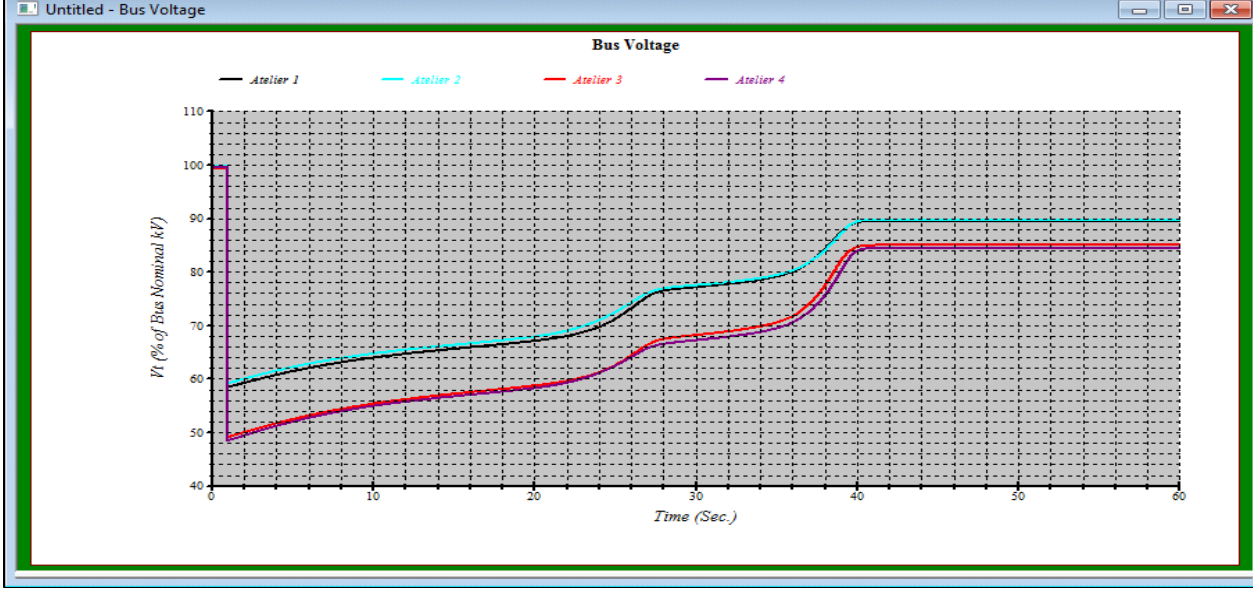
Figure 3: The voltage of the motors during the starting of the motors as a function of time. Source: Authors,